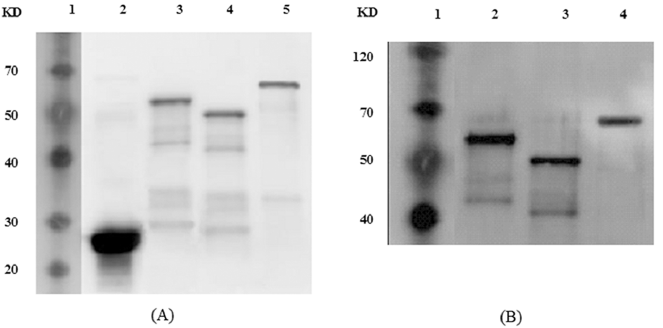
Fig 3. Western blot analysis of recombinant proteins. A (anti-GST rabbit mAb as primary antibody): Lane 1, low molecular weight protein marker; Lane 2, GST protein; Lane 3, roVP1 protein; Lane 4, roVP2 protein; Lane 5, roVP3 protein. B (rabbit anti-CSBV IgG as primary antibody): Lane 1, low molecular weight protein marker; Lane 2, roVP1 protein; Lane 3, roVP2 protein; Lane 4, roVP3